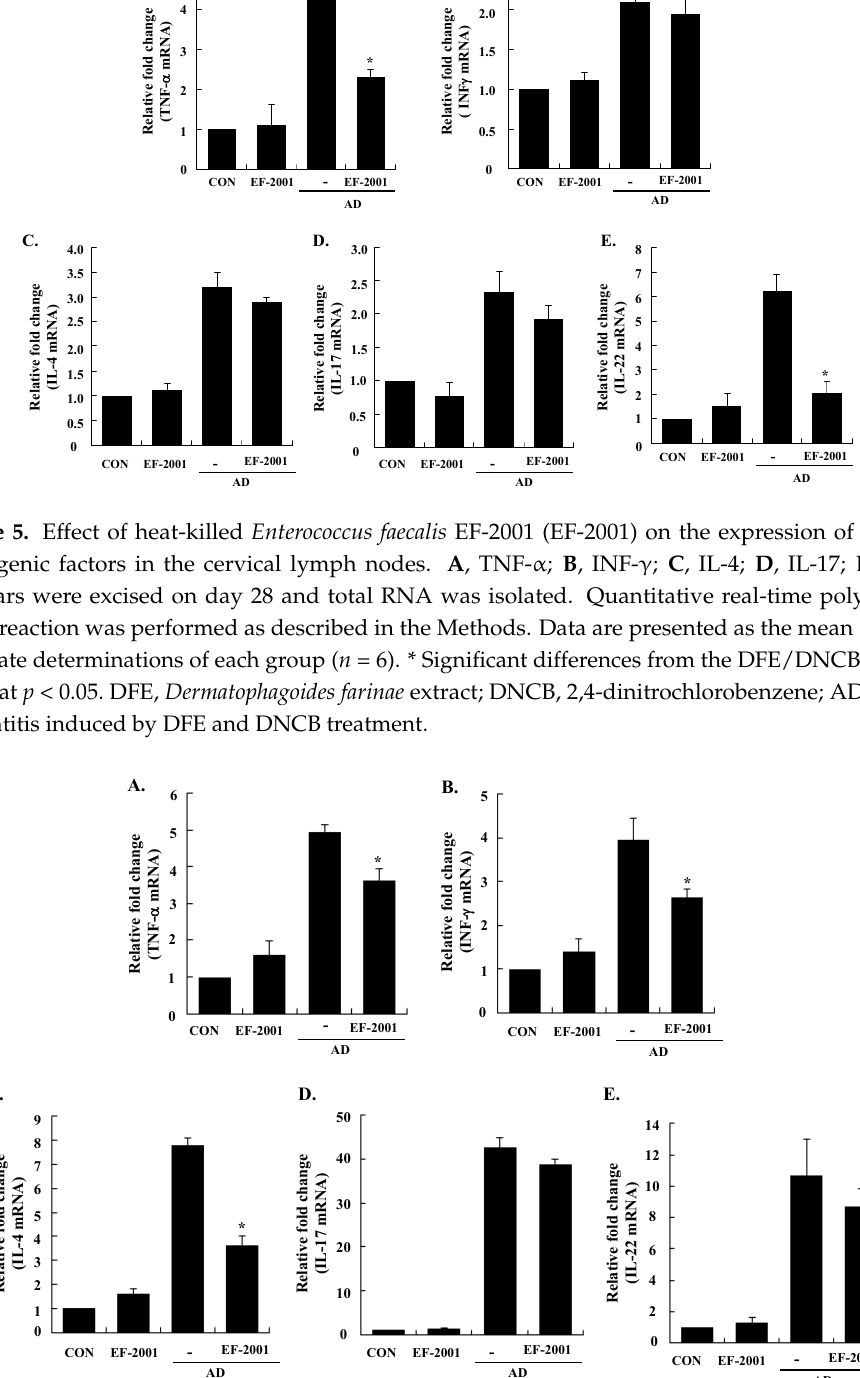
Figure 6. Effect of heat ‐ killed Enterococcus faecalis EF ‐ 2001 (EF ‐ 2001) on the expression of various pathogenic factors in the splenocytes. A , TNF ‐α ; B , INF ‐γ ; C , IL ‐ 4; D , IL ‐ 17; E , IL ‐ 22. The ears were excised on day 28 and total RNA was isolated. Quantitative real ‐ time polymerase chain reaction was performed as described in the Methods. Data are presented as the mean ± SD of triplicate determinations. * Significant differences from the DFE/DNCB ‐ treated value at p < 0.05. DFE, Dermatophagoides farinae extract; DNCB, 2,4 ‐ dinitrochlorobenzene; AD: atopic dermatitis induced by DFE and DNCB treatment.